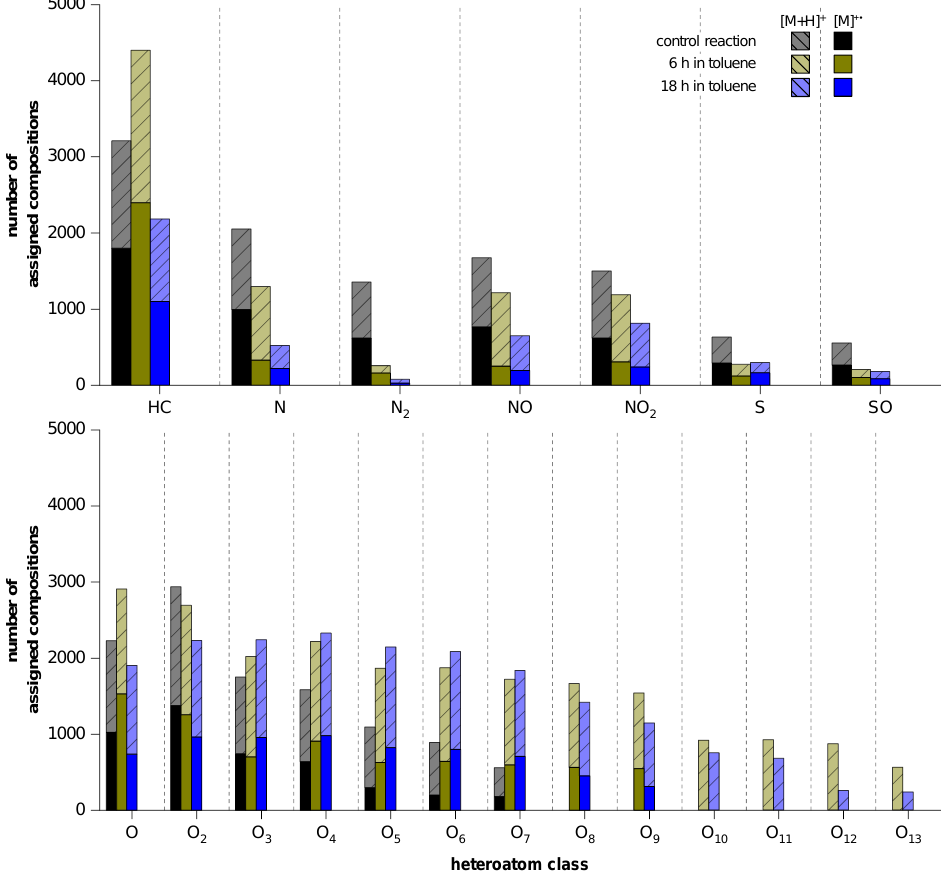
Figure 3. Population-based class distribution of the most prominent heteroatom classes ( top ) and oxygenated compounds ( bottom ) for control reaction (black), ozonation within 6 h in toluene (dark yellow) and within 18 h in toluene (blue).